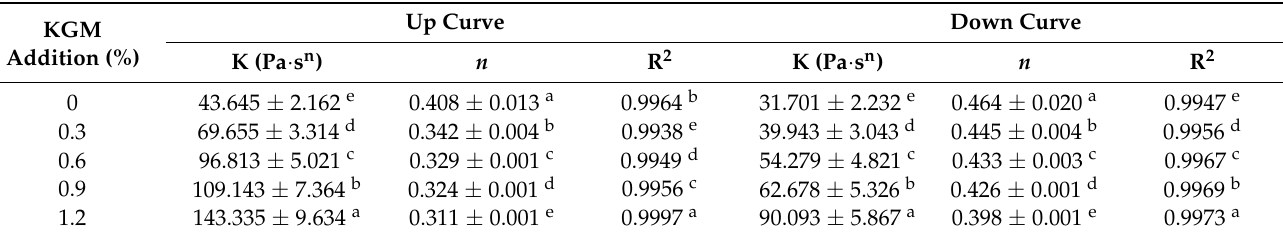
Table 2. Flow properties for CS/KGM mixtures.